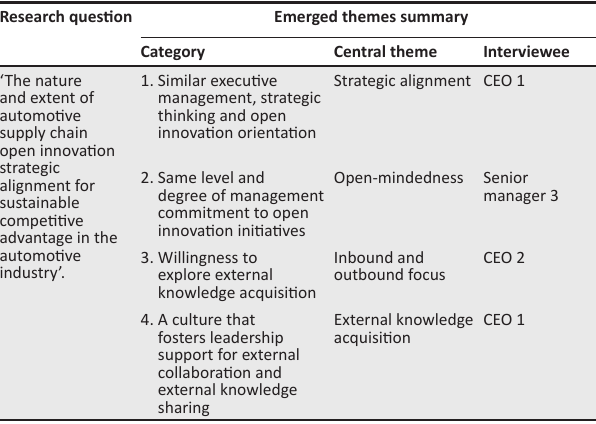
TABLE 2: Emerged